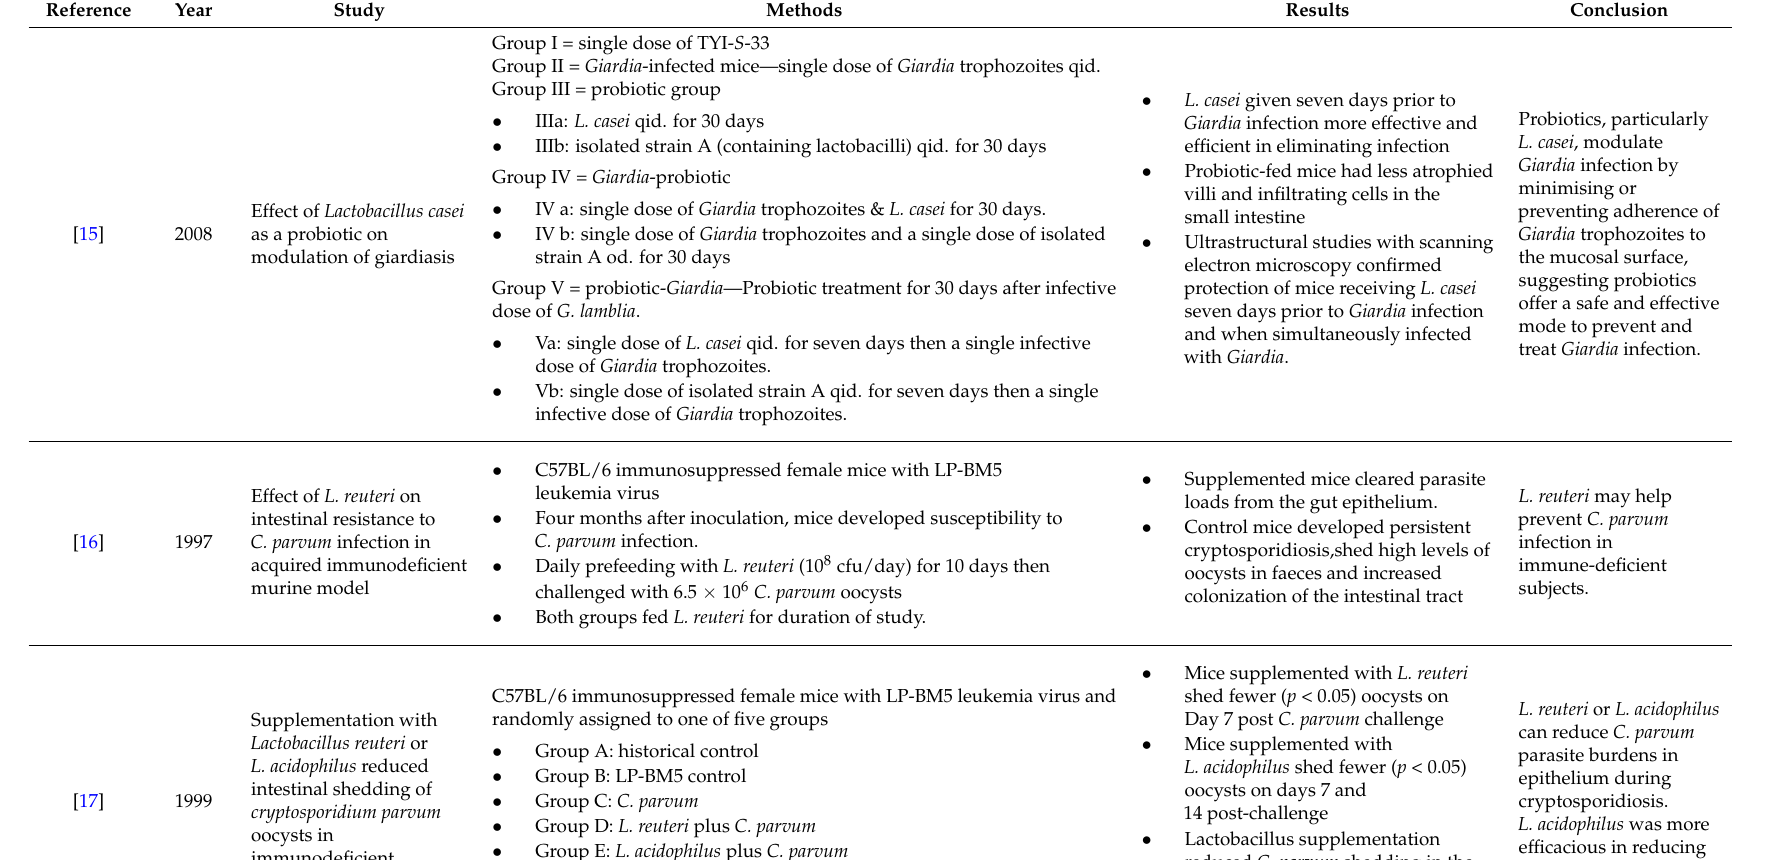
Table 1. Laboratory animal studies on the administration of probiotics to eradicate protist